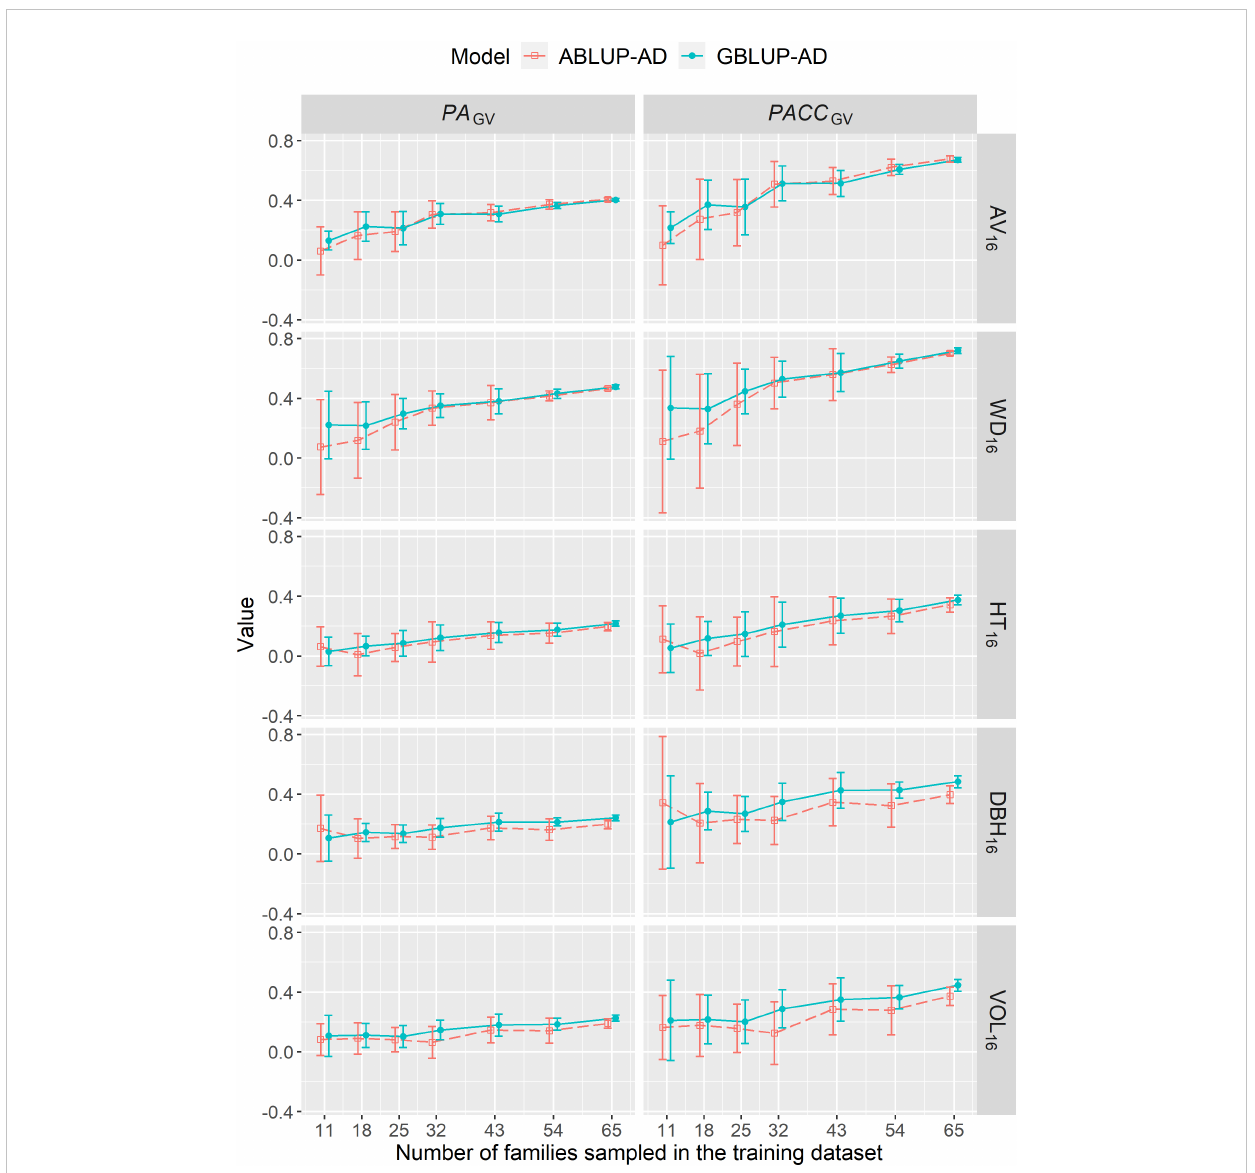
FIGURE 4 For dataset 1, average across-site predictive ability ( PA GV ) and prediction accuracy of genetic values ( PACC GV ) estimated using CV2 and when varying the number of families sampled in the training dataset using the ABLUP-AD and GBLUP-AD additive-dominance models. The error bars represent the standard deviations of estimates across the 10 replications for each level of number of families sampled. See Table 2 for a description of